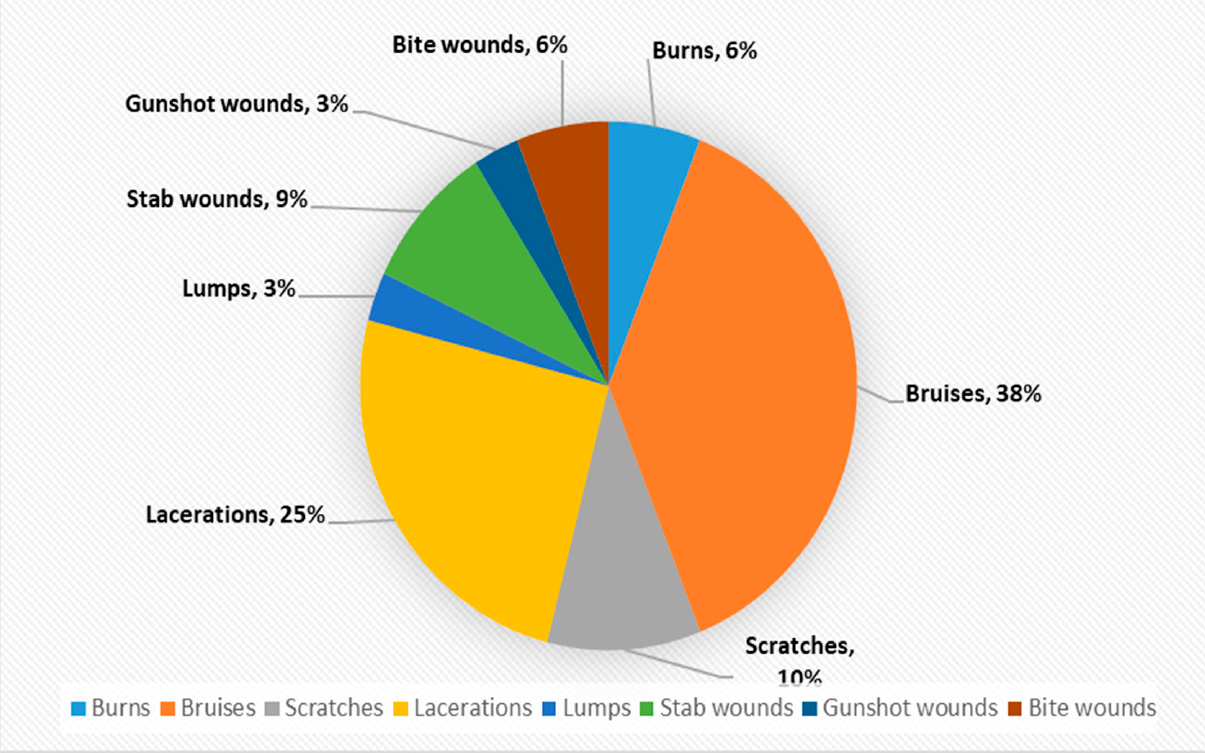
Figure 4. Composition of skin injuries as a % ( n = 32).